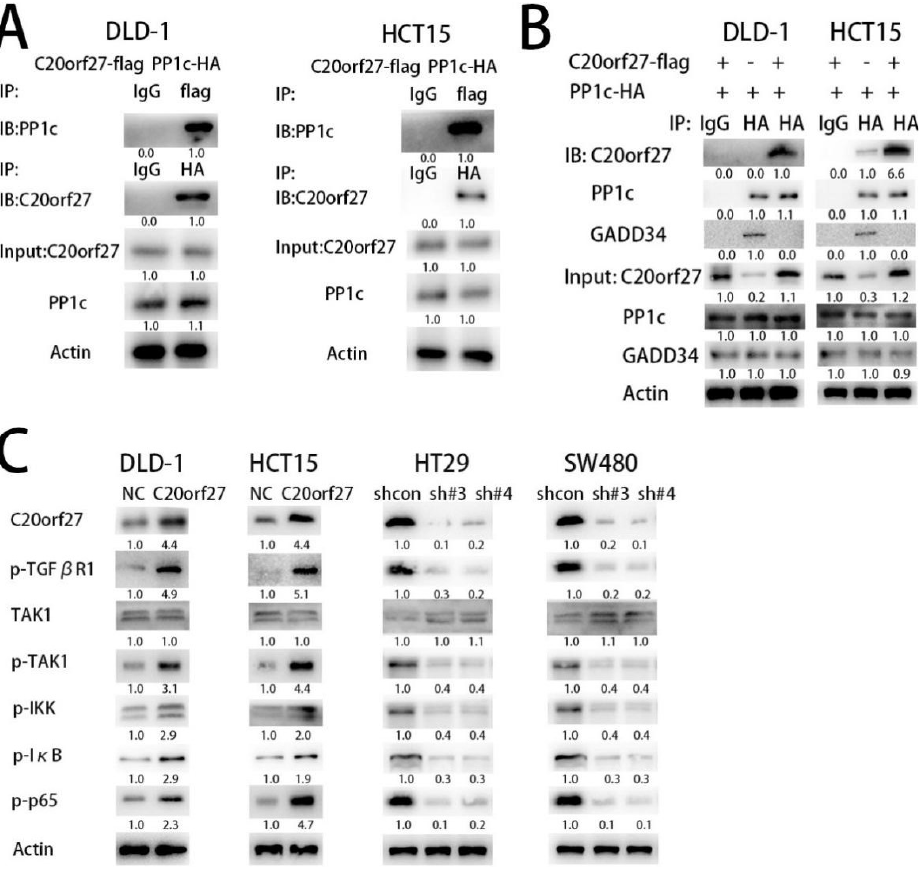
Figure 5. C20orf27 activates thee TGF β R-TAK1-NFkB pathway through interaction with PP1c. ( A ) PP1c binding with C20orf27 was validated by CoIP assay; ( B ) HA-tagged PP1c plasmid was transfected into the cells with or without C20orf27 -Flag overexpression. CoIP demonstrated that the interaction between PP1c and GADD34 was reduced with C20orf27 overexpression; ( C ) Western blot analysis for the expression of p-TGF β R1, p-IkB, p-TAK1, p-IKK, and p-p65 in C20orf27 overexpressing and silencing